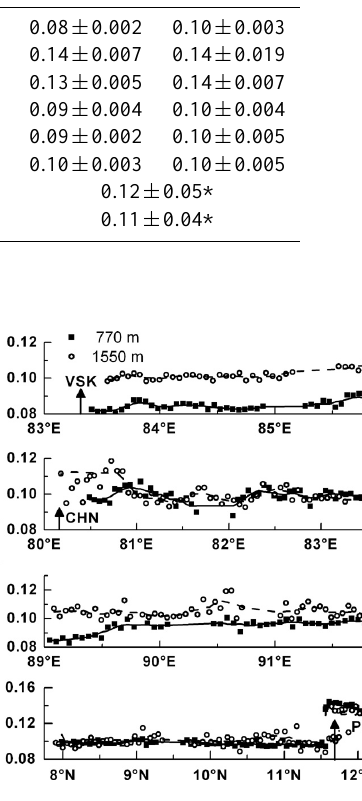
Fig. 16. Longitudinal/latitudinal variation of hemispheric back scat- ter ratio ( b ) during bi-level sorties (a) off-VSK (BL1, first panel), (b) off-CHN (BL6, second panel), (c) off-PBR (westwards, BL4, third panel), (d) off-PBR (north-south, BL3+BL5, fourth panel). Solid line and dashed lines indicates 5 point running mean at 770m and 1550m altitudes, respectively. The arrows indicate the corre- sponding base stations’